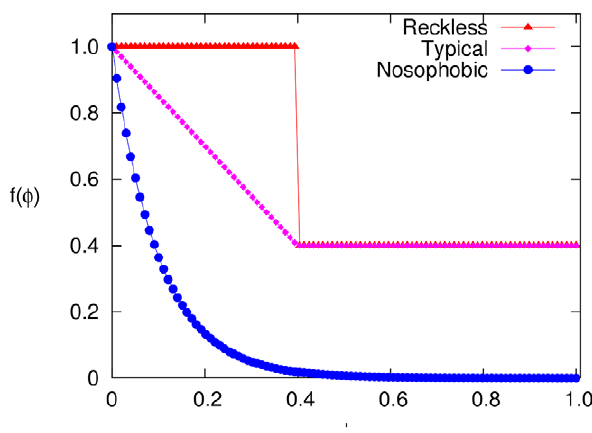
Figure 3. Adaptive fear factor. The ‘‘fear factor’’ f ( w ) depending on the global infected fraction w (see Eq. 5) associated with different behavioral patterns listed in section